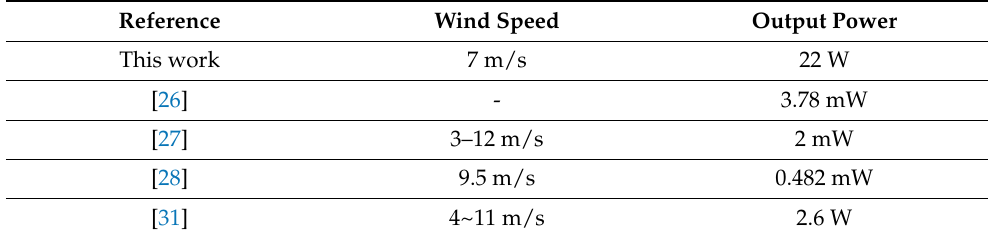
Table 4. Performance comparison of various wind-energy harvesters using a piezoelectric material with wind